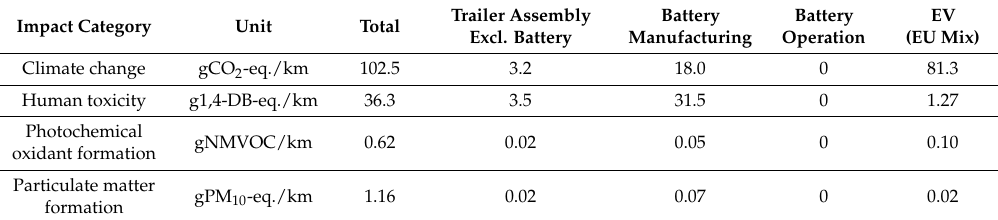
Table 6. LCIA of the 40 kWh EV + battery